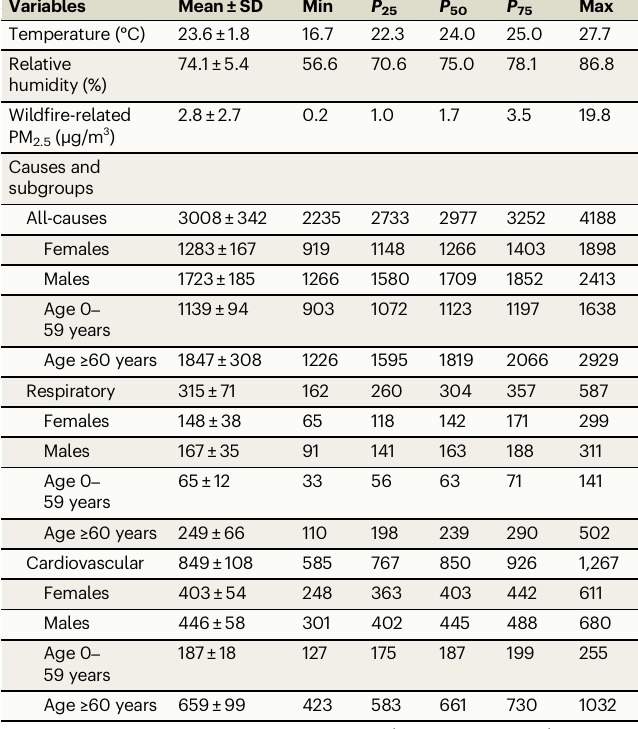
Table 1 | Summary statistics of daily mean values of meteor- ological variables, air pollutants and cause-speci fi c death counts in